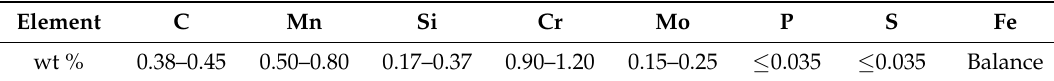
Table 2. Composition of 42CrMo high strength structural steel used for pads.